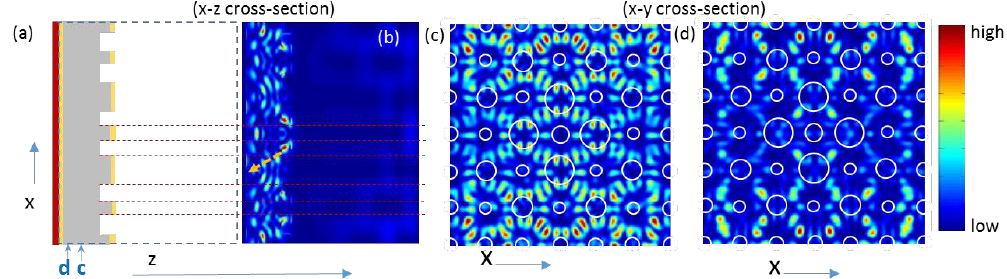
Figure 4. ( a ) Schematic of x-z cross-section of Si device patterned in GPSC with a unit cell of 6a × 6a at y = 0. C and d indicate the locations in z-direction for obtaining the x-y cross-section in ( c ) and ( d ). ( b ) E-field intensity of x-polarized light incident at 0 ◦ onto a GPSC-patterned Si device in x-z cross-section corresponding to ( a ). Dashed red lines indicate the boundary between Si and air inside the Si GPSC. Dashed yellow line indicates one of light propagation path. ( c – d ) E-field intensity in x-y cross-section in Si at z-direction locations corresponding to c and d in ( a ), respectively. White circles indicate the location under the GPSC Si.